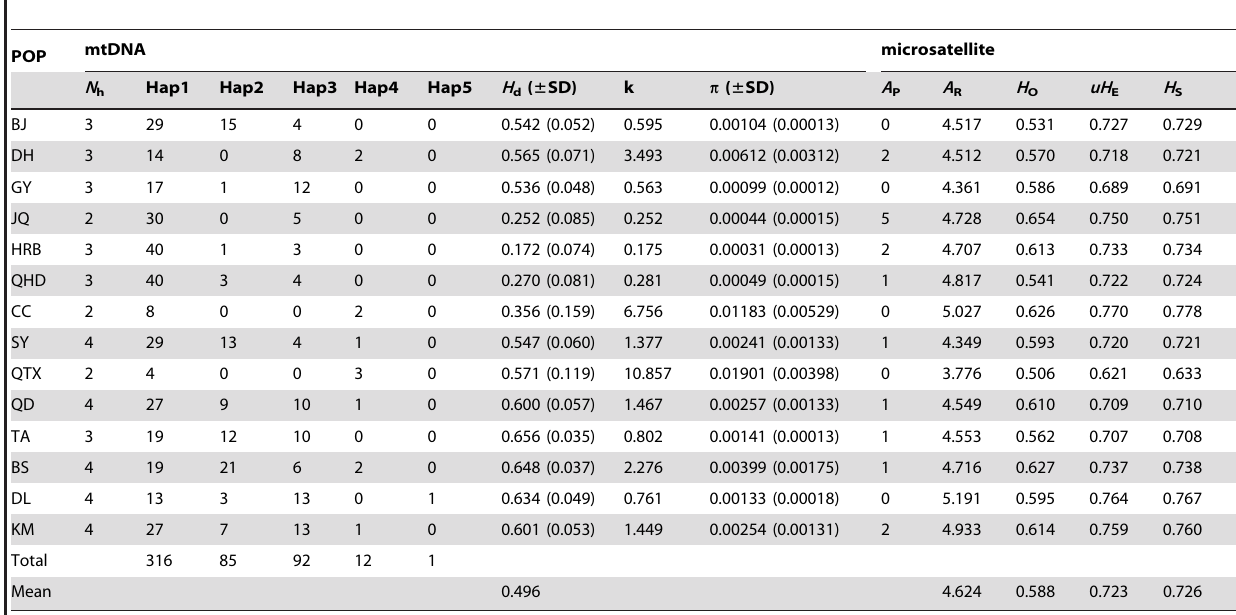
Table 3. Basic indices calculated using COI gene and ten microsatellites and haplotype distribution in Chinese populations.